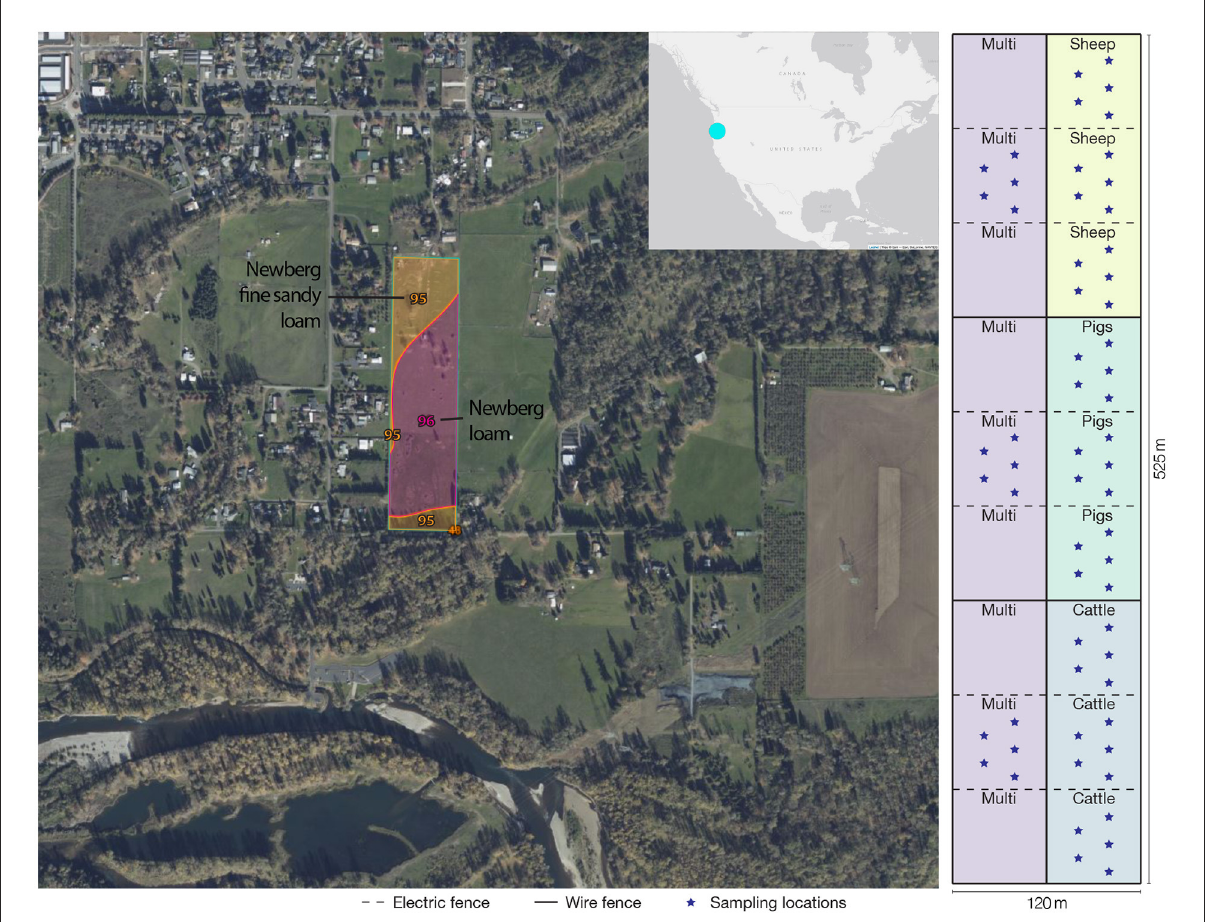
FIGURE1 Study farm location and diagram of paddock layout, grazing treatments, and approximate sample collection locations. To maintain a balanced analytical design, only three of the nine multi-species paddocks were sampled.